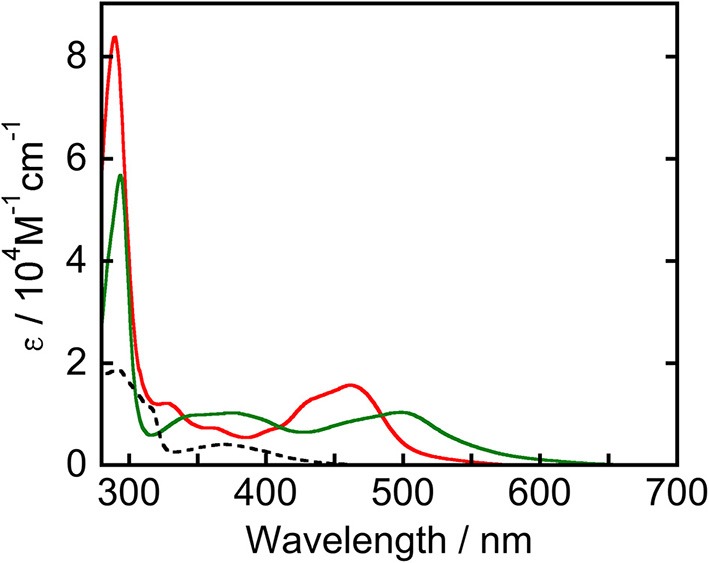
UV-vis absorption spectra of Ru(pic) (green line), Ru(dmb) (red line), and Re (broken line) measured in a DMA solution.